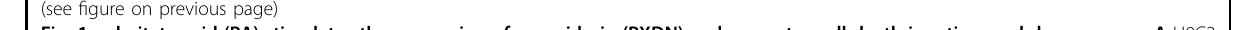
si-PXDN group (Fig. 4D and Fig. S1B). These results suggested that FoxO1 may act as a downstream factor of PXDN in PA-medicated autophagosome accumulation